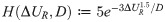
Phenomenological model dissects core mechanisms of noise-enhanced coding.a) In the reduced system, leftward exits reset the right barrier, effectively lowering it; the right barrier evolves according to the dotted curve ΔU(t) in Fig 3c. b) The firing rate dependence on D for the non-phasic model (classic, with constant right boundary and no left boundary), a model with a dynamic spike threshold only, and the full phasic model (see Eqs (8) and (24)). c) The vector strength r computed by the analytic formulas for all 3 models (Eq (25)). d) The noise-enhanced encoding q of a sinusoidal input for the three models. Throughout we set H(ΔUR,D)≔5e-3ΔUR1.5/D to capture the sensitivity of ν to noise (cf. Figs 1d) and 4b), and φ = 0.1.